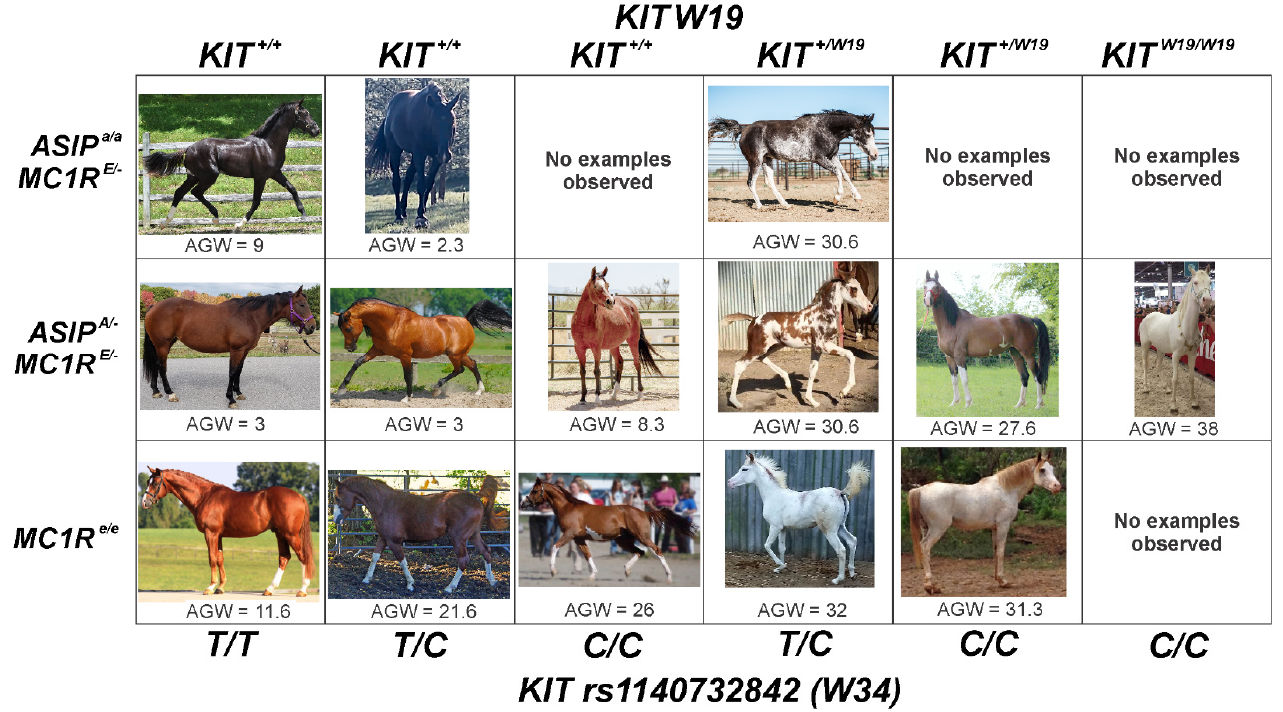
Figure 4. Phenotypic examples of the rs1140732842 ( W34 ) and compound W19 allele action in different MC1R Extension and ASIP Agouti loci, as well as respective Average Grade of White (AGW) scores.